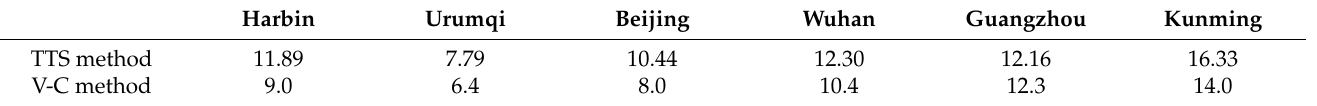
Table 8. Outdoor humidity ratio recommended by representative cities in transition season, (g/kg dry